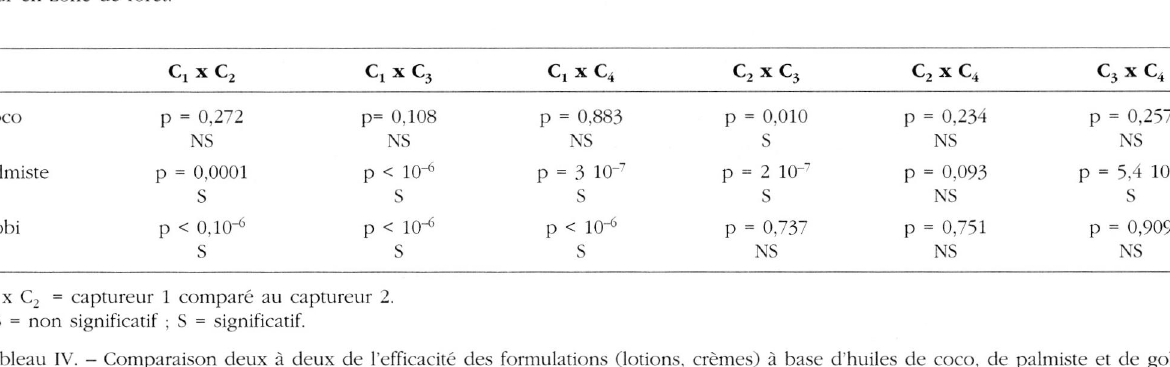
Tableau III. - Variabilité de l'efficacité des formulations (lotions, crèmes) à base d'huiles de coco, de palmiste et de gobi selon le captu reur en zone de forêt.